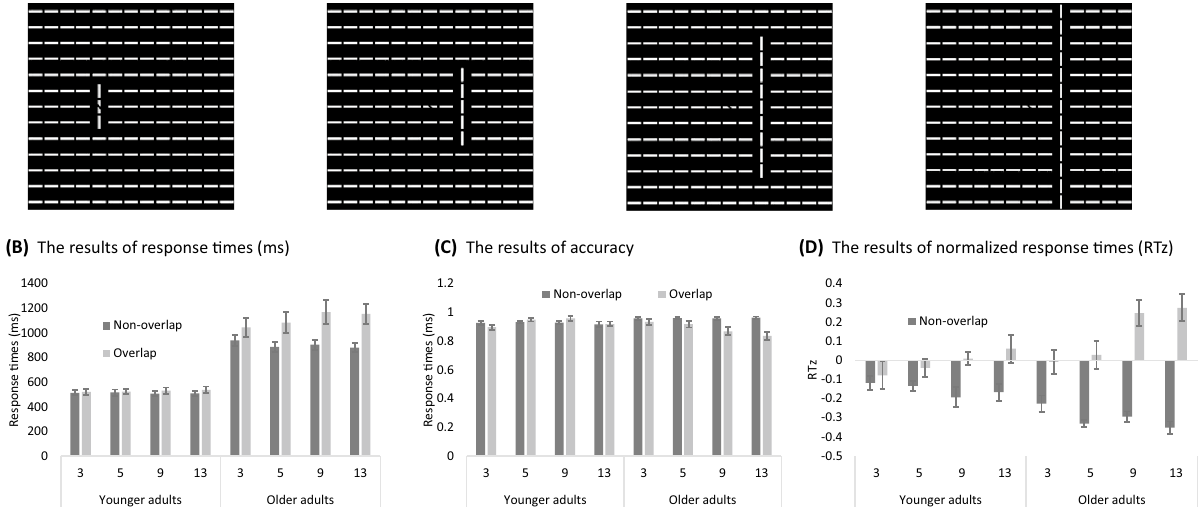
Figure 4. The examples of four distractor length conditions ( A ) and the results of younger and older adults in each condition in response times ( B ), accuracy ( C ), and normalized response times ( D ) in experiment 2. The length of the collinear distractor was 3-bar, 5-bar, 9-bar, and 13-bar. The target could overlap with the collinear distractor (the 3-bar case) or be non-overlapped (the 5-, 9-, and 13-bar cases). ( B ) Response times, accuracy ( C ), and normalized response time (RTz, D ) for the younger and older adults are plotted according to distractor length and target type (overlap or non-overlap). Error bars represent the standard error of the